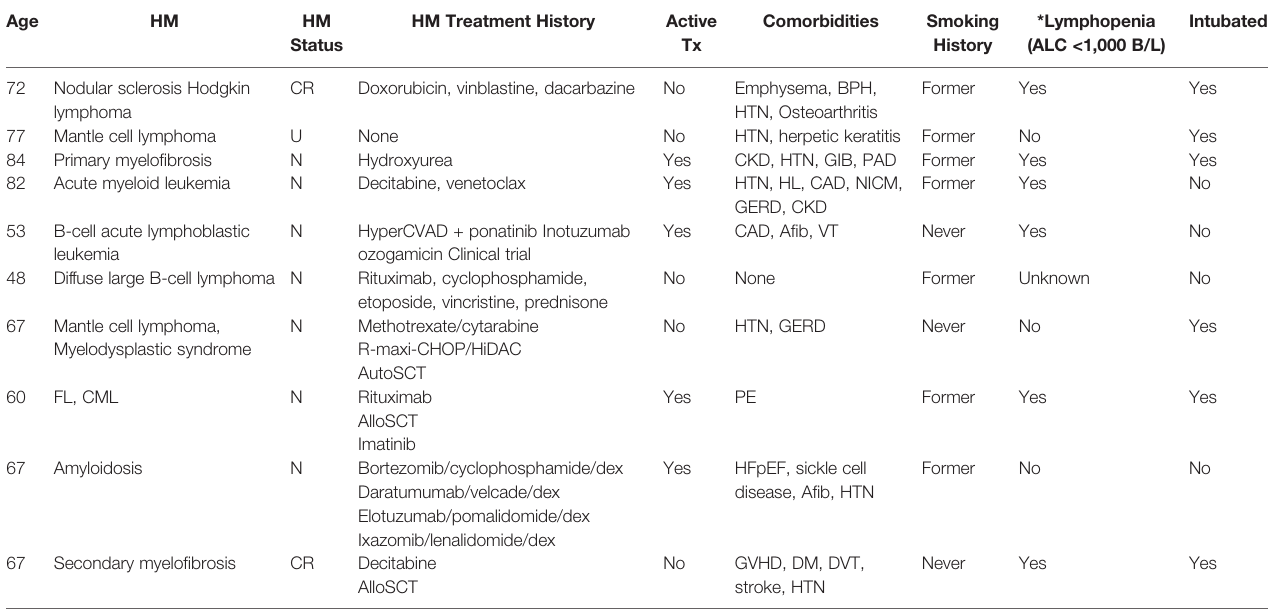
TABLE 2 | Characteristics of Patients with HM who Died from